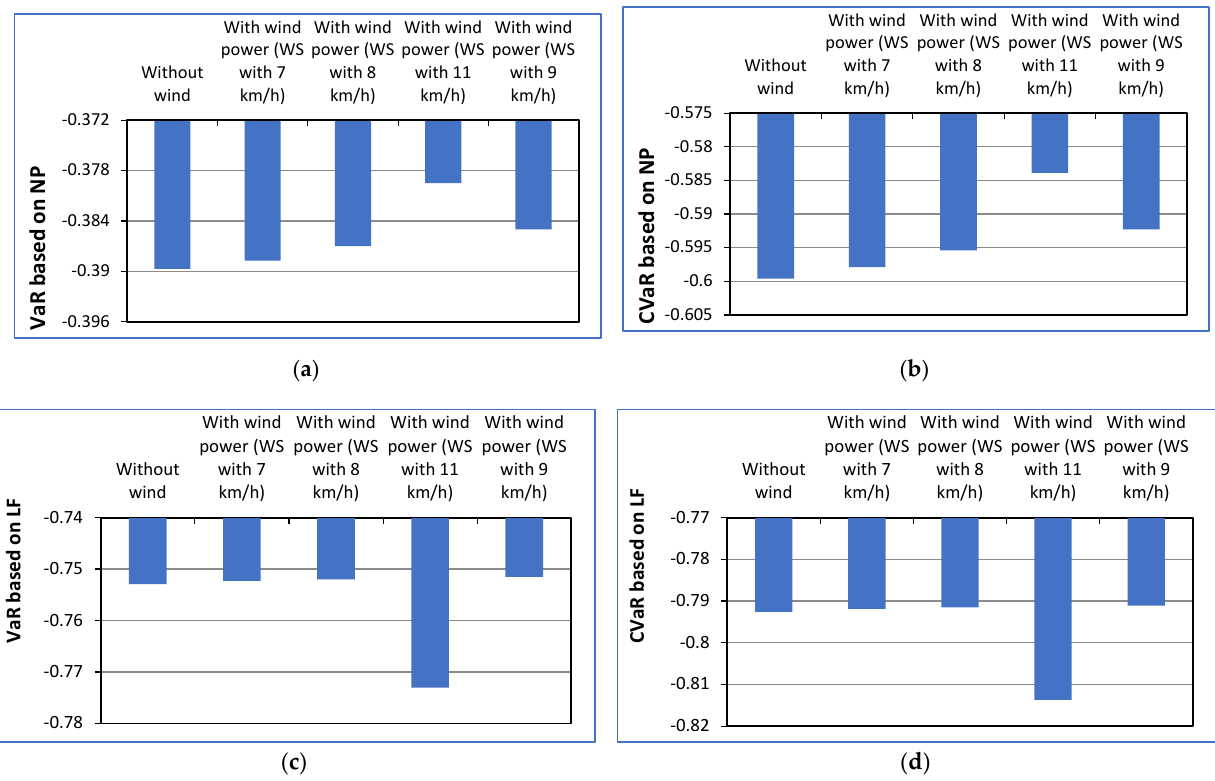
Figure 5. System Risk with Wind Power Integration (Mumbai @Base Case). VaR based on NP ( a ), CvaR basd on NP ( b ), VaR based on LF ( c ), CvaR based on LF ( d ).